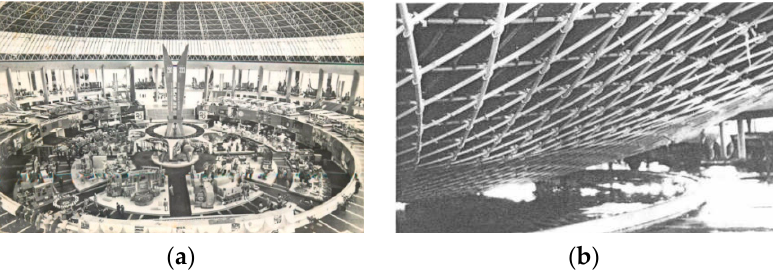
Figure 3. Mechanism of collapse of the Bucharest, Romania, cover in 1963 [32,39], ( a ) inside view before collapse, ( b ) inside view after collapse.